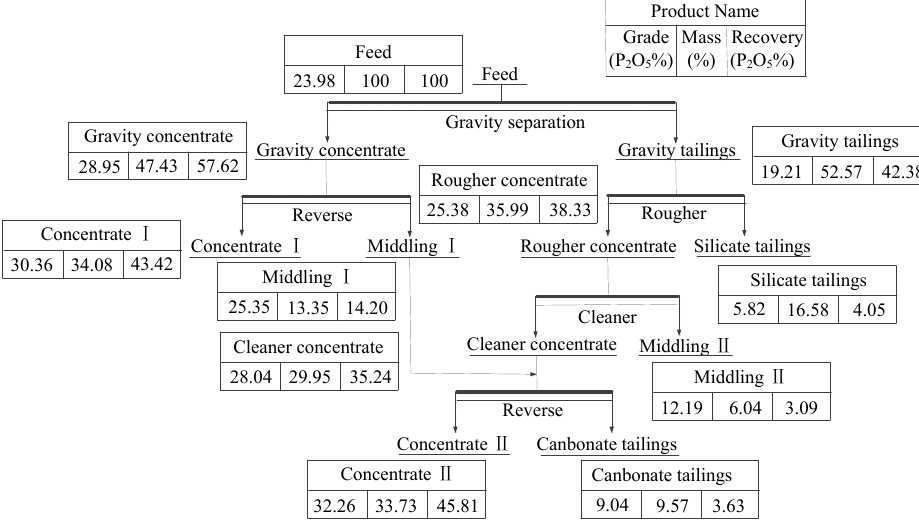
Figure 12. Quantity-quality flow-sheet of improved process.